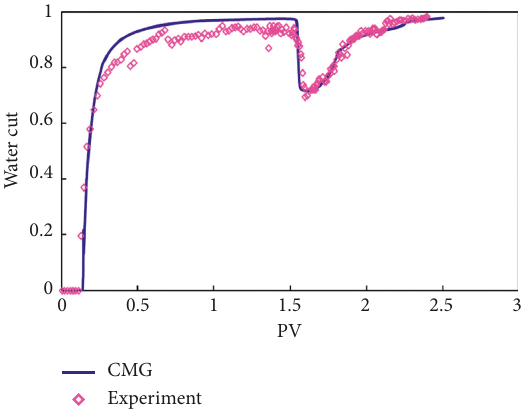
Figure 26: History matching result of water cut.